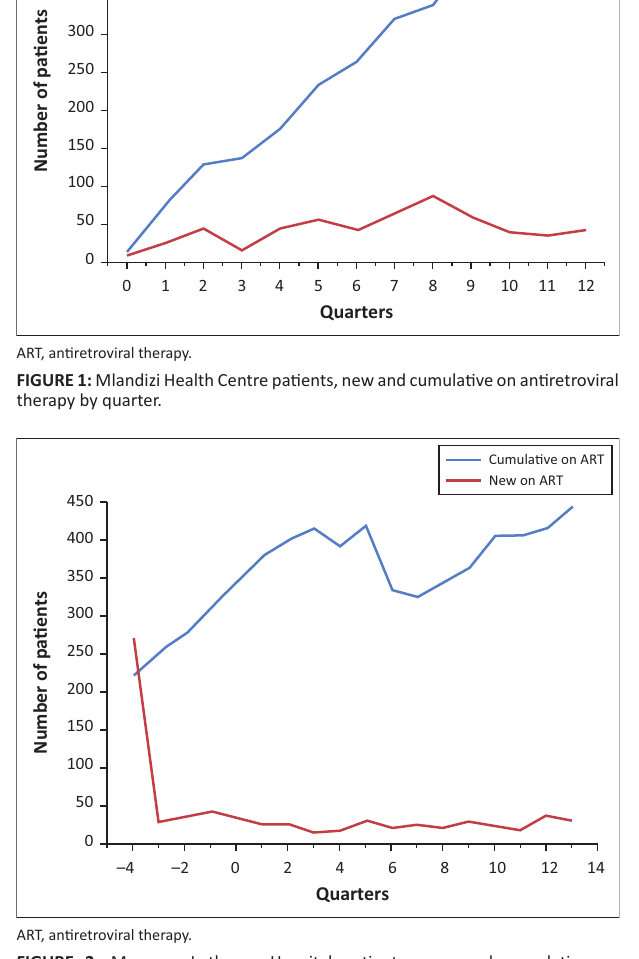
ART, antiretroviral therapy. FIGURE 2: Marangu Lutheran Hospital patients, new and cumulative on antiretroviral therapy by quarter.